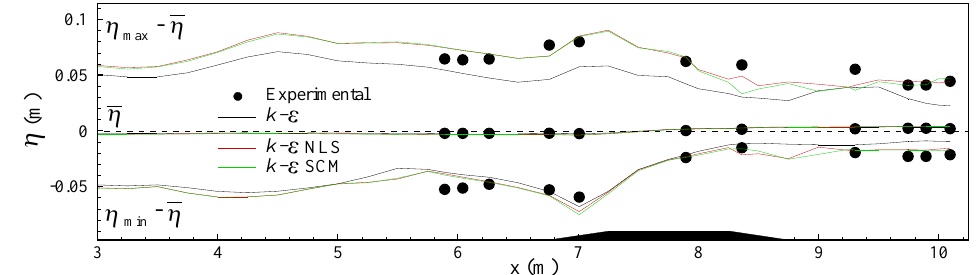
Figure 19. Maximum and minimum wave height envelopes and mean water level of k- ε , k- ε NLS and k- ε SCM models and the experiment (dash line indicates the still water level), T p = 3.2 s, H s = 0.10 m. Table 5. Bias and NRMSE of wave height at the 11 sections of measurement for regular and random waves for the k - ε , k - ε NLS and k - ε SCM turbulence